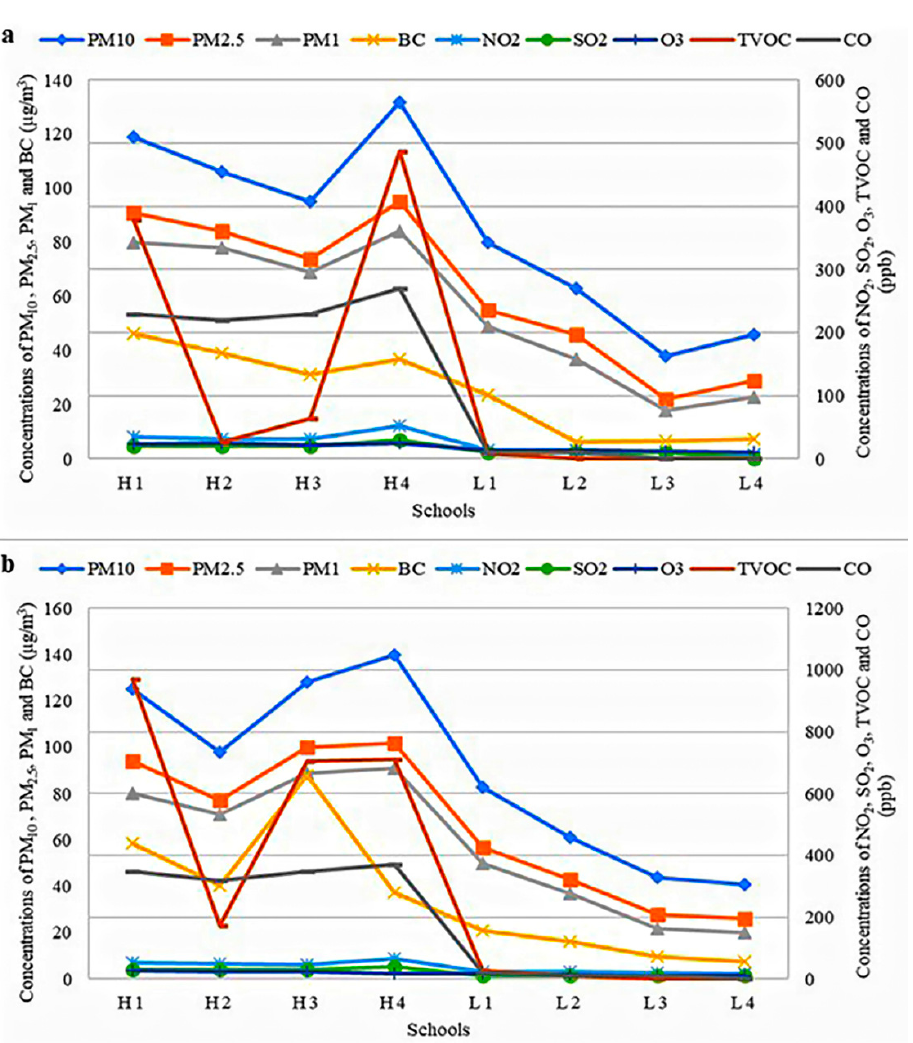
Figure 2. Average of ( a ) indoor and ( b ) outdoor air pollutants of the selected schools for five school days.